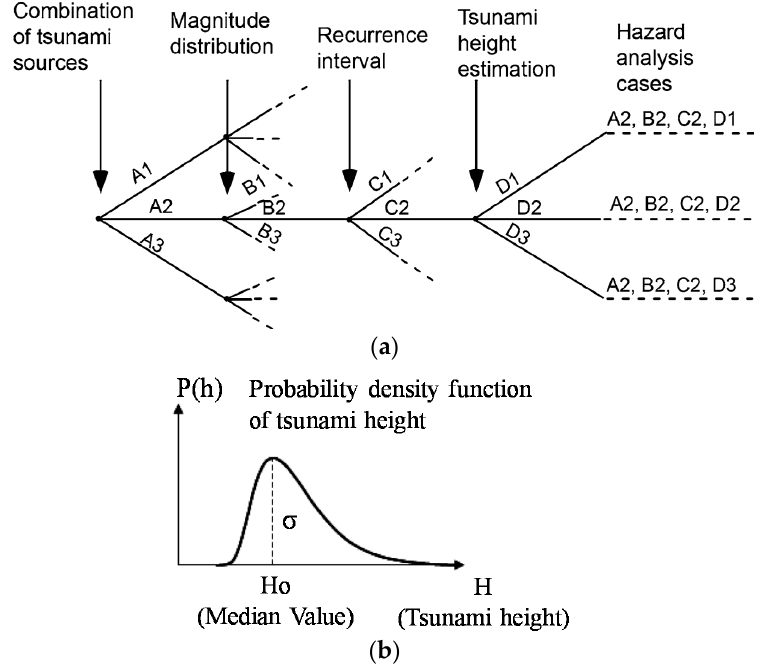
Figure 1. A diagram of the evaluation methods for the ( a ) epistemic uncertainty using a logic tree [10] and ( b ) aleatory uncertainty using a probabilistic density function [13].